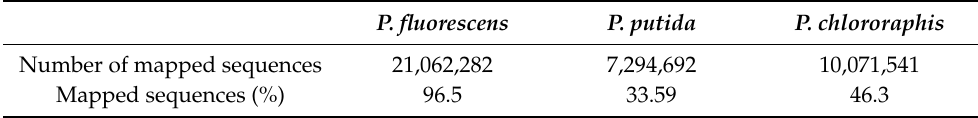
Table 2. The results of mapping to reference genomes.